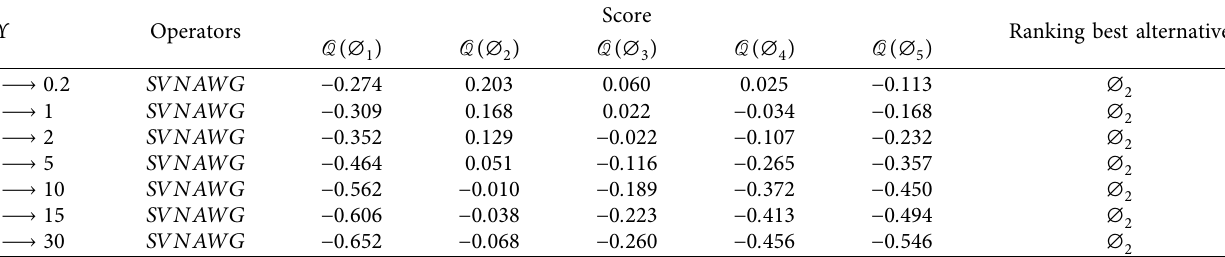
Table 11: Sensitivity analysis of parameter ℘